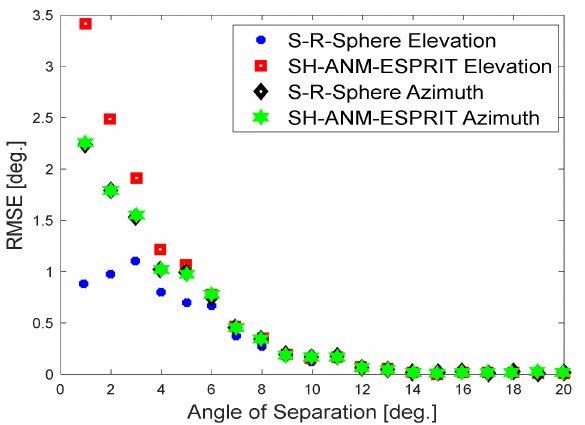
Figure 2. Error in DOA estimation against angle of separation in an ideal (no noise) single snapshot scenario.